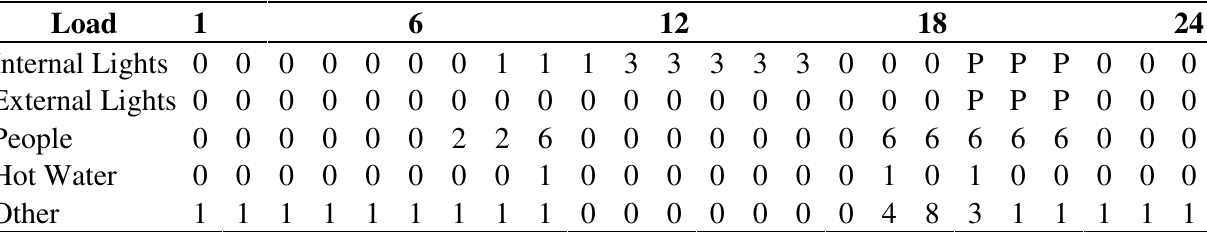
Table 2. Load profile for internal gains for weekend.